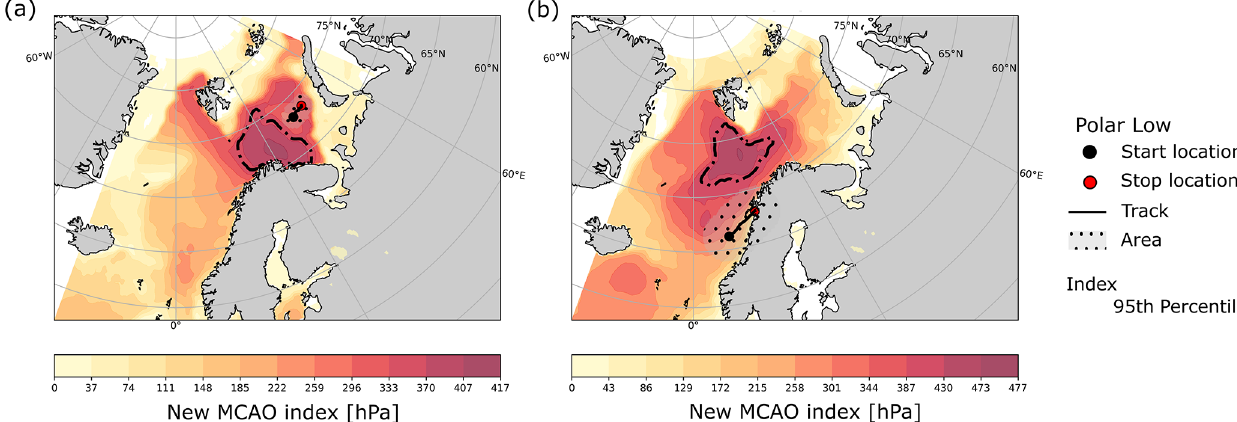
Figure C1. Examples of PL events that were not captured by the new MCAO index. (a) PL event on 4 March 2010. (b) PL event on 13 March 2011. The area with the highest index values, delineated by the 95th percentile (dashed black line), does not overlap with the area of observed PLs